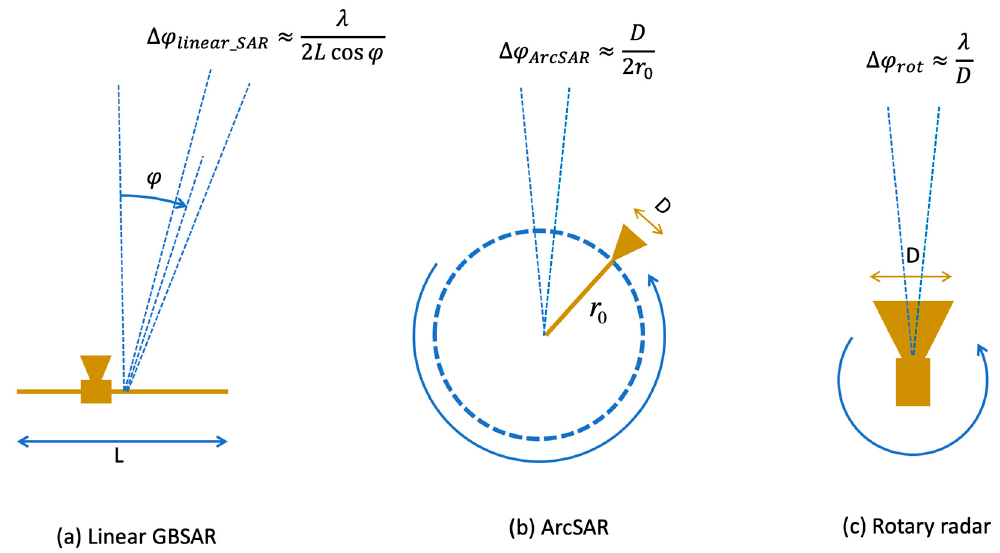
Figure 14. Angular resolution of Linear GBSAR ( a ), ArcSAR ( b ), and rotary radar ( c ).